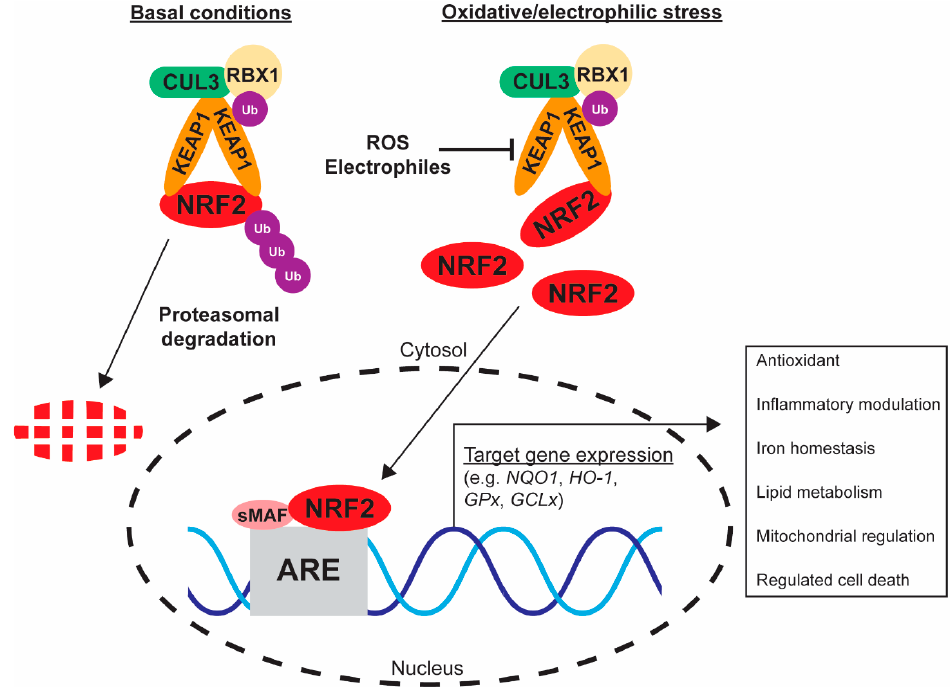
Figure 2. KEAP1-mediated regulation of NRF2 under basal and stressed intracellular environments. Basally, NRF2 is bound by a KEAP1 homodimer and retained within the cytosol. KEAP1 forms an E3 ubiquitin ligase complex via associations with CUL3-RBX1 and ubiquitinates NRF2, priming for subsequent proteasomal degradation. Increased ROS or electrophilic modification of KEAP1 cysteine residues perturbs the NRF2–KEAP1 interaction. De novo NRF2 is able to translocate to the nucleus, heterodimerise with sMAF proteins and bind to antioxidant response element (ARE) genetic sequences to drive target gene expression.